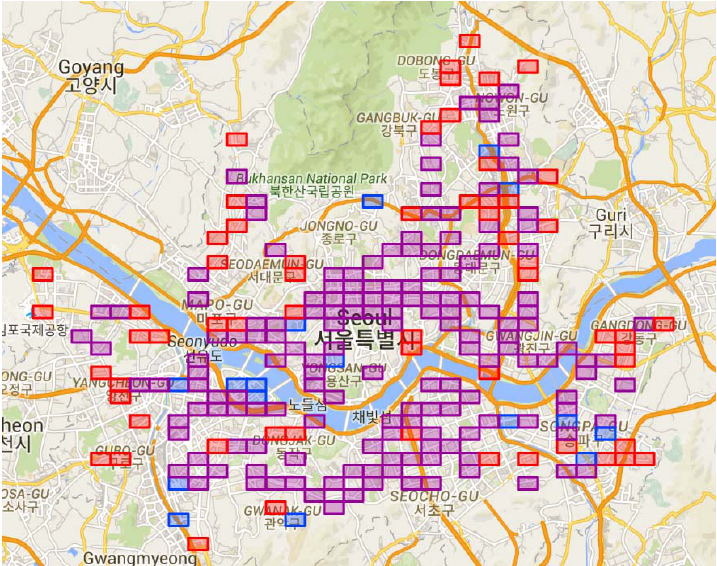
Figure 4. HIRs extracted in Seoul. 159 HIRs in purple both for morning and evening commutes, 16 HIRs in blue only for morning commute, and 59 HIRs in red only for evening commutes.